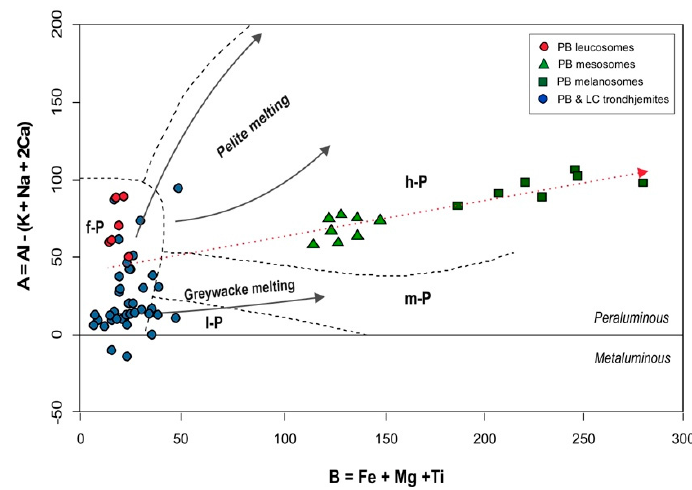
Figure 8. AB diagram ([92]; after [93]) for the studied magmatic rocks. The arrows represent the compositions of progressive melt fractions produced by experimental melting of metapelites and metagreywackes ([92]; and references therein). Compositions of the trondhjemites from Pizzo Bottino (PB; [19]) and the nearby Forte Cavalli granitoid complex (FC; [15]) are also shown in the diagram.